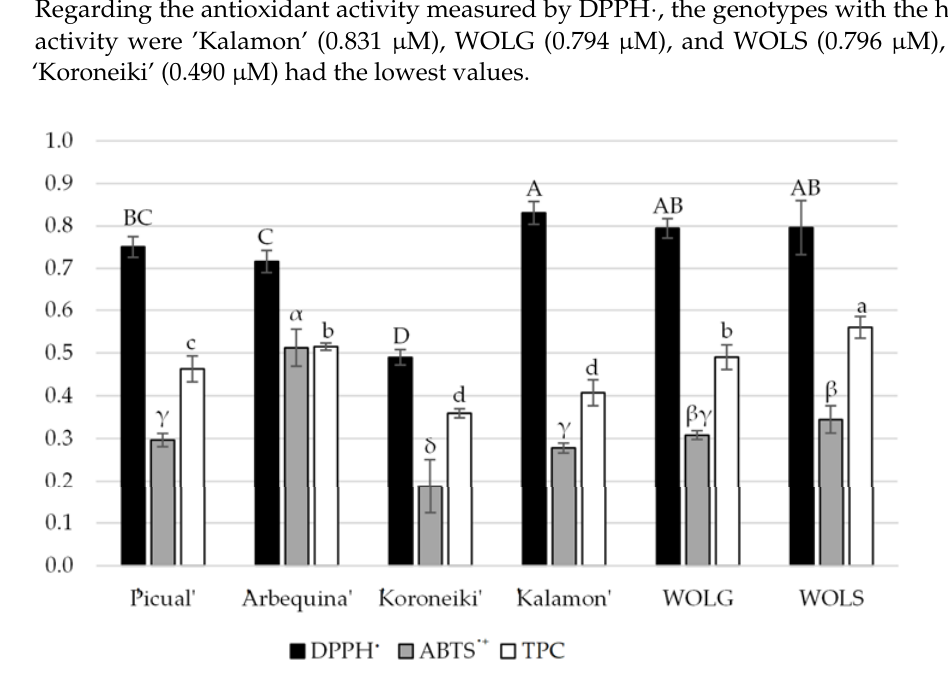
Figure 4. Antioxidant activity determined by DPPH · and ABTS · + methods ( µ M Trolox) and total phenol content (TPC) determined by Folin–Ciocalteu (mg/mL GAE) in olive leaves. WOLG: wild olive leaves ( O.e . spp. oleaster ) from Greece; WOLS: wild olive leaves ( O.e . spp. Oleaster ) from Spain. Different capital, Greek, and lower case letters indicate significant differences among genotypes analyzed by the same method according to the Tukey’s HSD ( α <